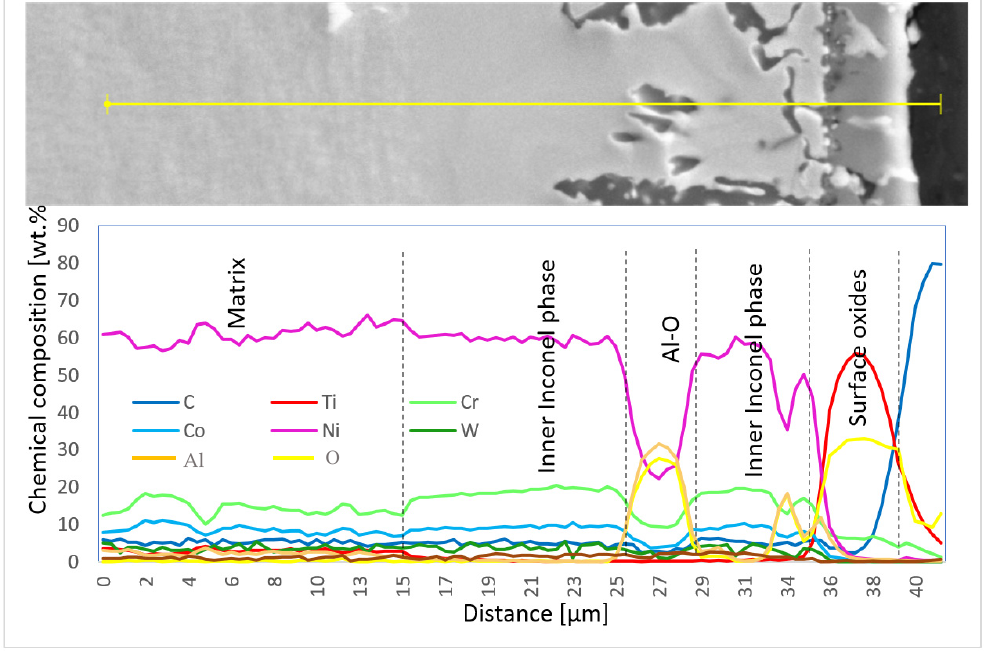
Diagram 4. Chemical composition (wt.%) of elementary lines on the 100R sample after He exposure.